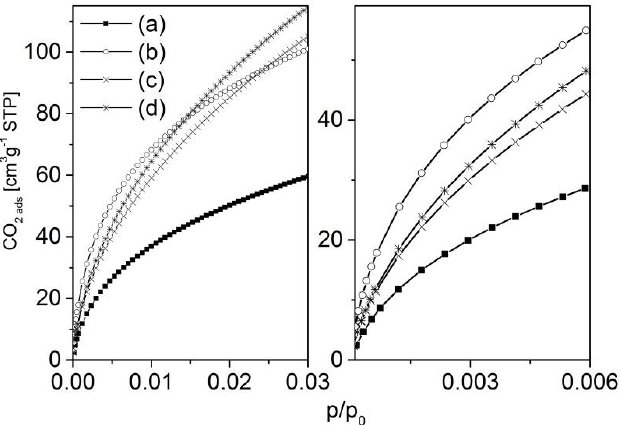
Figure 8. Carbon dioxide adsorption isotherms of the samples 873-0M (a); 873-3M (b); 873-12M (c); 873-16M (d). Materials 2016 , 9 , 214